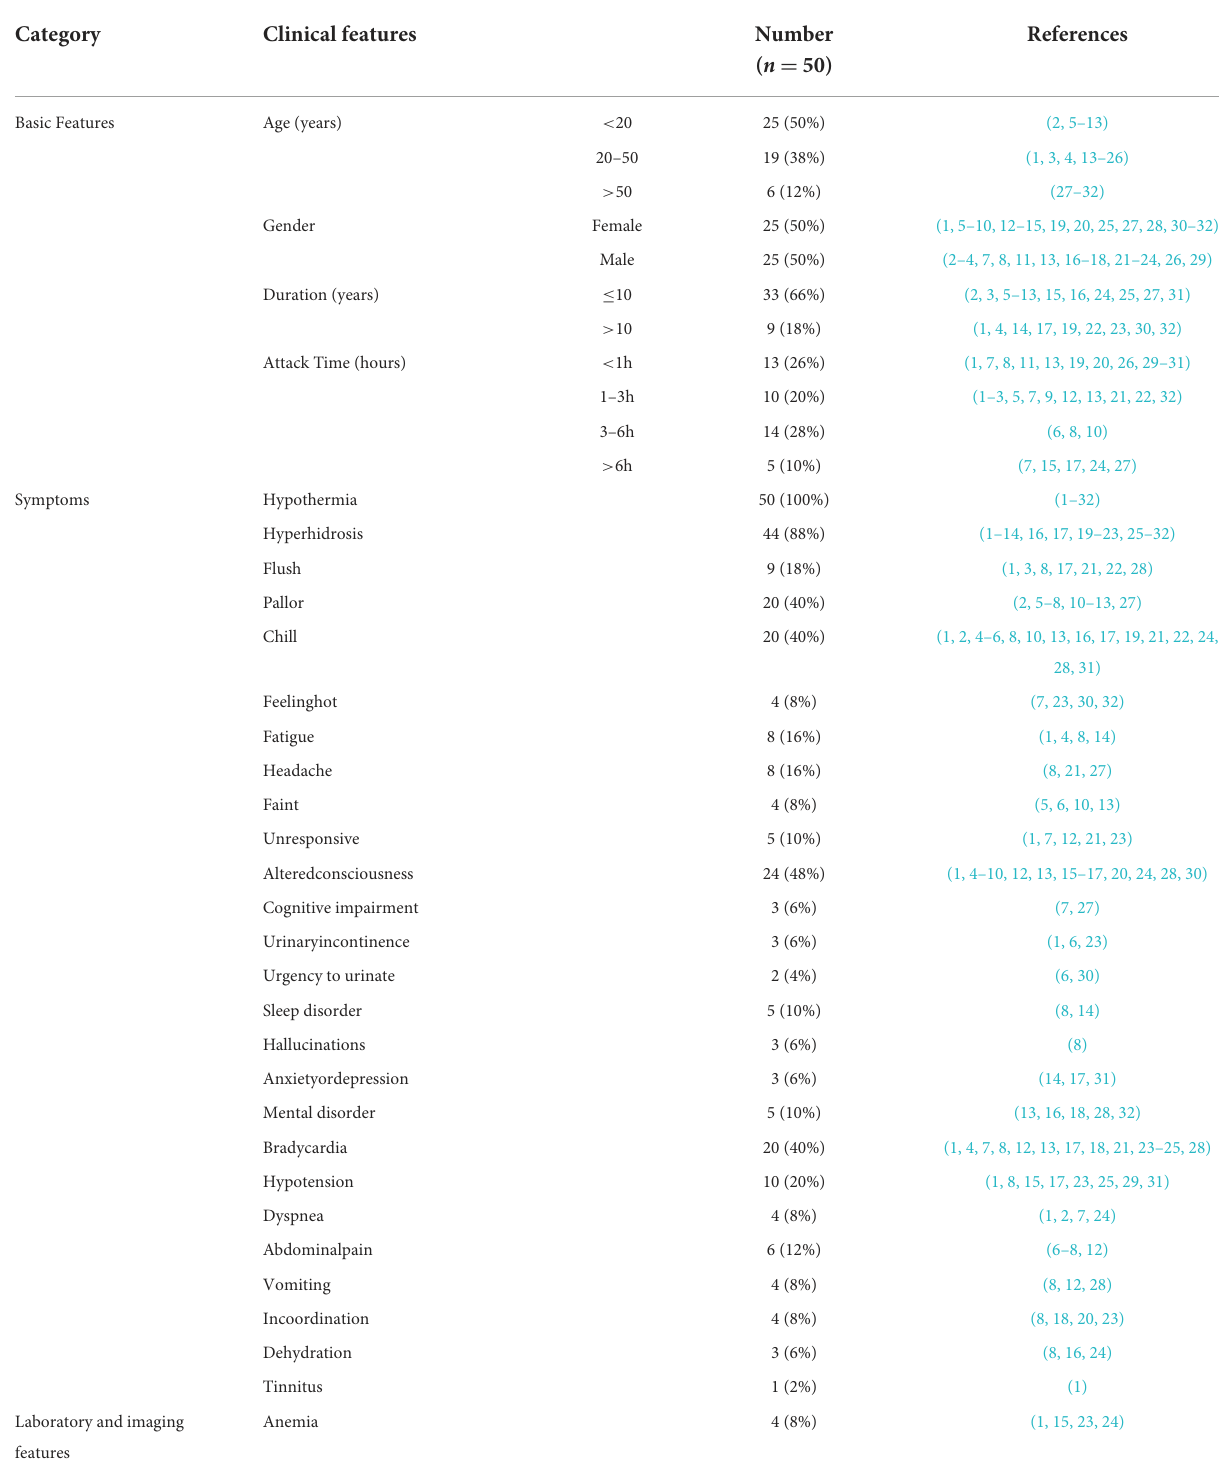
TABLE 1 Articles and characteristics of patients with Shapiro’s